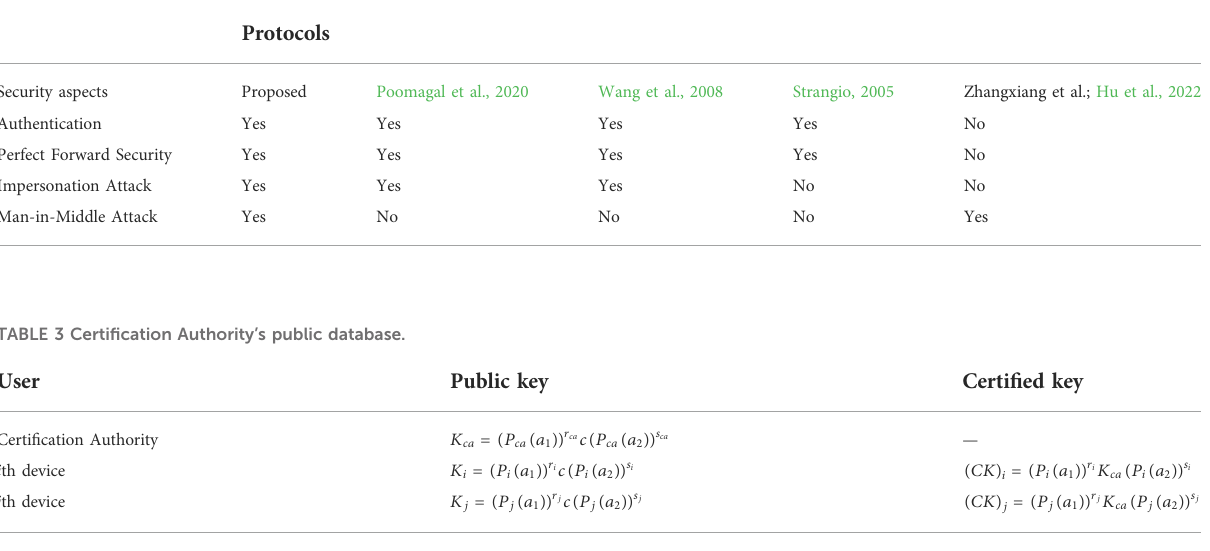
TABLE 2 Comparison of security in some existing protocols.